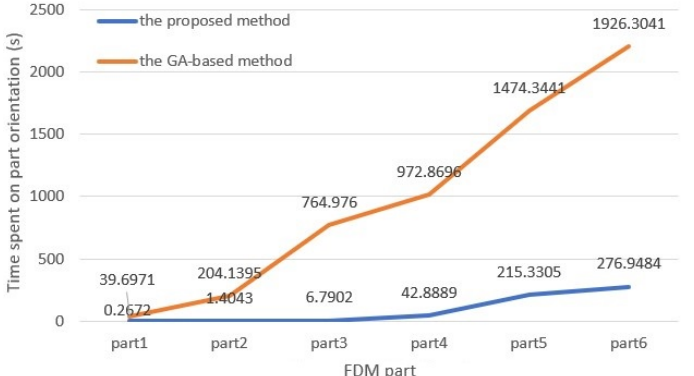
Figure 13. Results of the efficiency comparison.